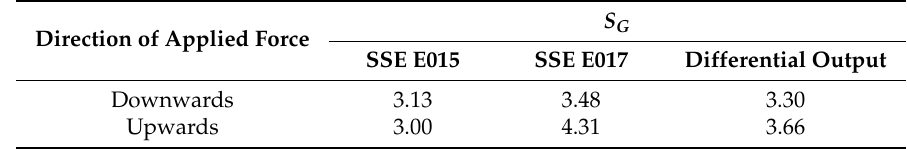
Table 4. Values of gage factor of strain gages alone and differential output obtained with force applied in the downward and upward directions.